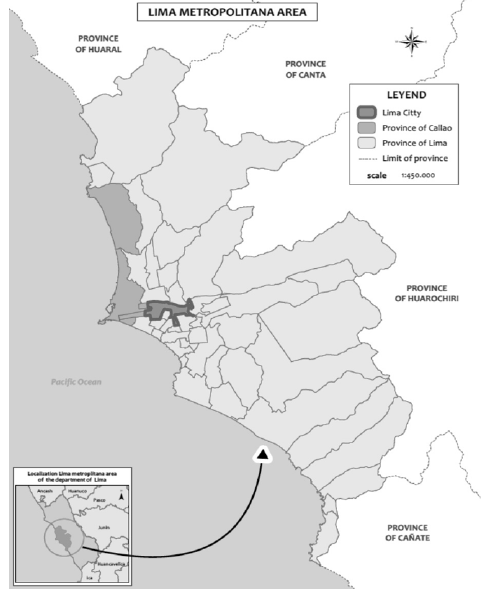
Figure 6: Metropolitan Area of